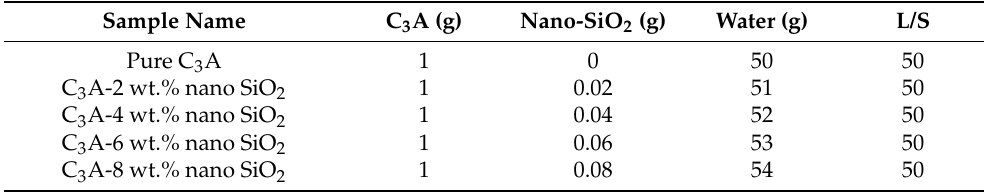
Table 1. Proportion of different components used during the preparation of the